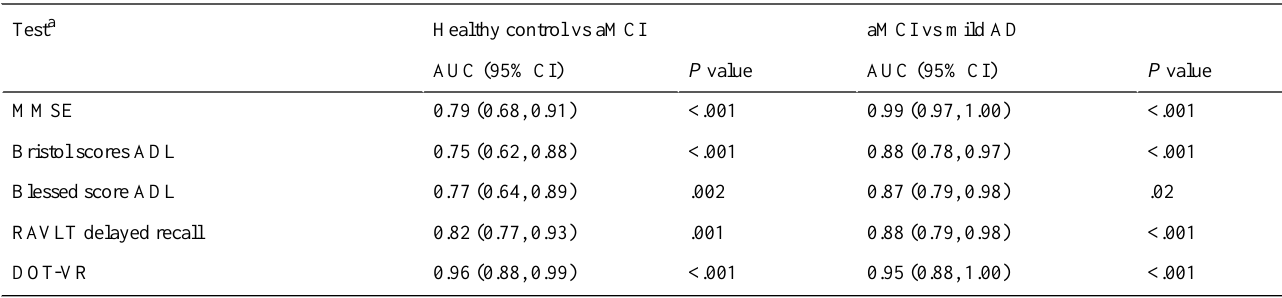
Table 3. Area under the curve (AUC) for standard neuropsychological test scores and Virtual Reality Day-Out Task (VR-DOT) for healthy controls versus patients with amnestic-type mild cognitive impairment (aMCI) and patients with aMCI versus patients with mild Alzheimer-type dementia (AD).